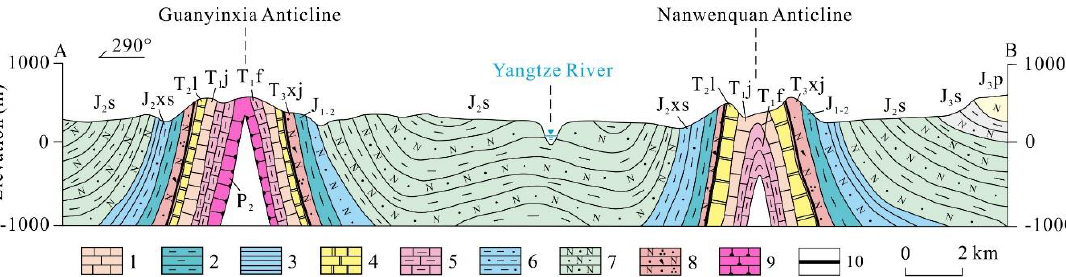
Figure 3. Geological cross-section along line A–B in Figure 1. (approximate vertical exaggeration = 2.5). Legend: 1. Limestone; 2. Mudstone; 3. Shale; 4. Dolomite; 5. Marl; 6. Arenaceous mudstone; 7.